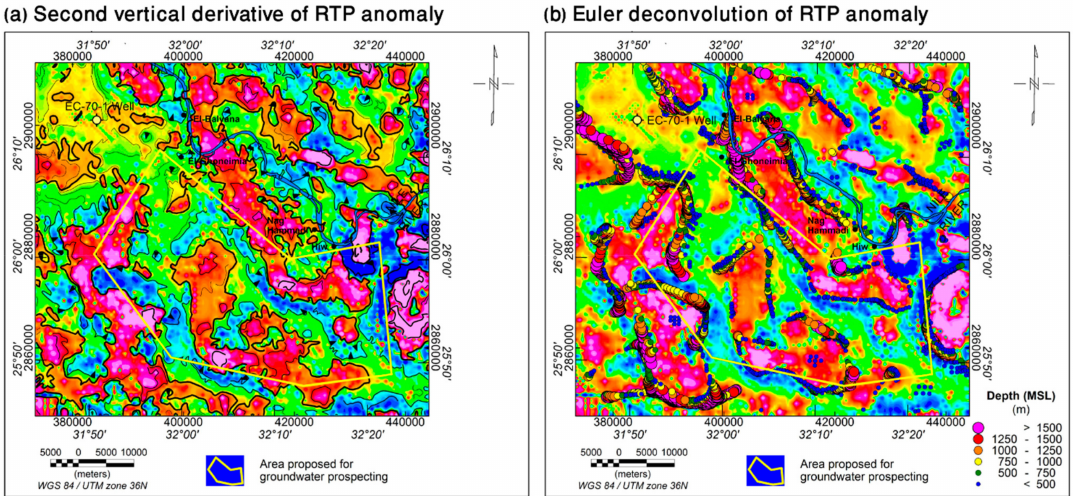
contacts and faults by relating these boundaries to the inflection point of the anomaly marginal gradient.